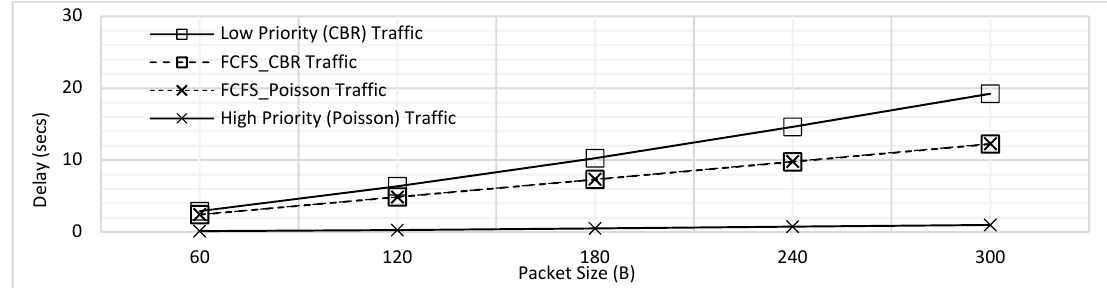
Figure 7. Delay Comparison for with and without Prioritization (Figures 3 and 5 Combined).